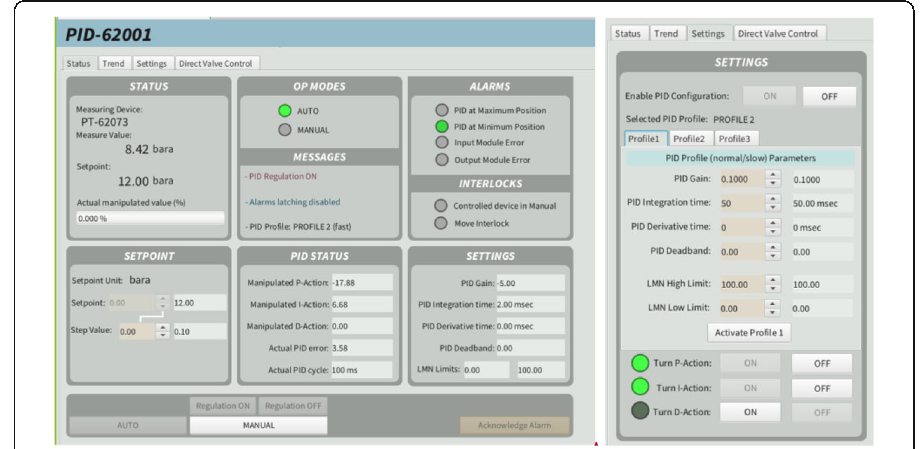
Fig. 14 Control Valve with PID controller and the PID